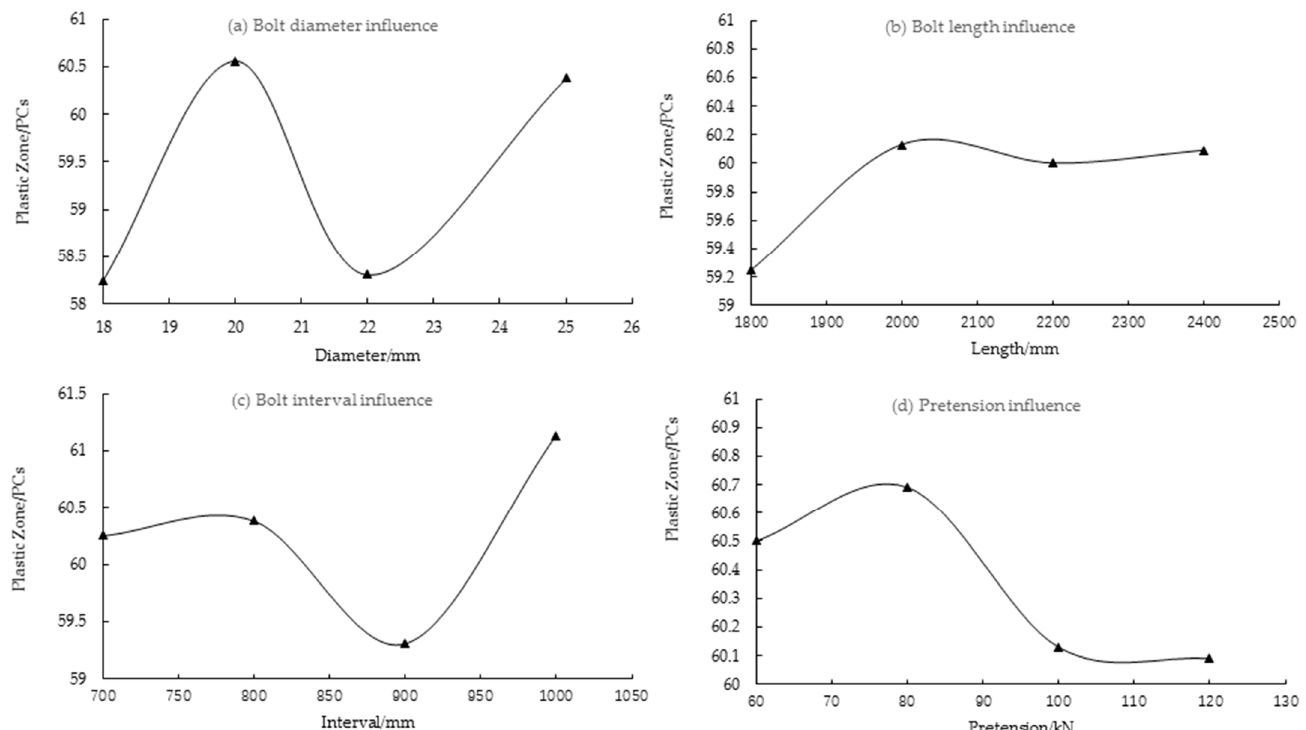
Figure 10. The variation of plastic zone size of surrounding rock under the different factors. ( a ) Bolt diameter influence; ( b ) Bolt length influence; ( c ) Bolt interval influence; ( d ) Pretension influence. Table 8. Results and analysis of the plastic yield zone under four different influencing factors.